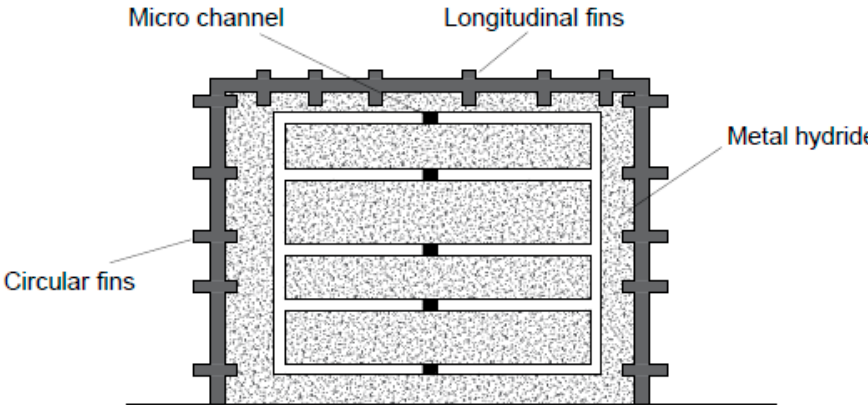
Figure 4. Schematic of micro-channel reactor.